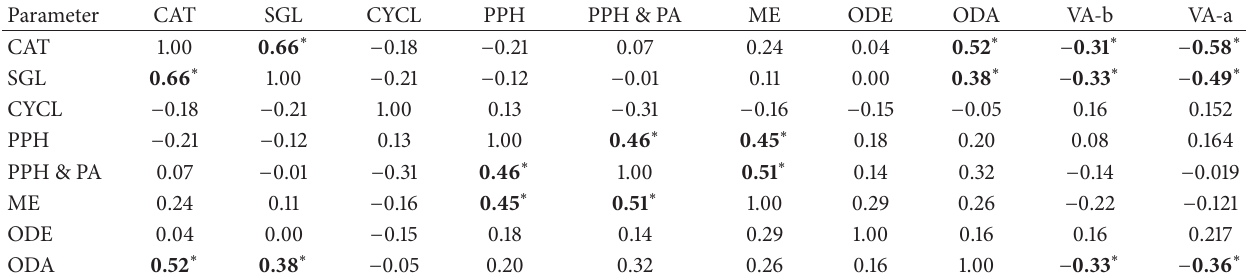
Table 5: Matrix of correlation parameters: anterior and posterior eye segments, visual acuity (VA before-after treatment).